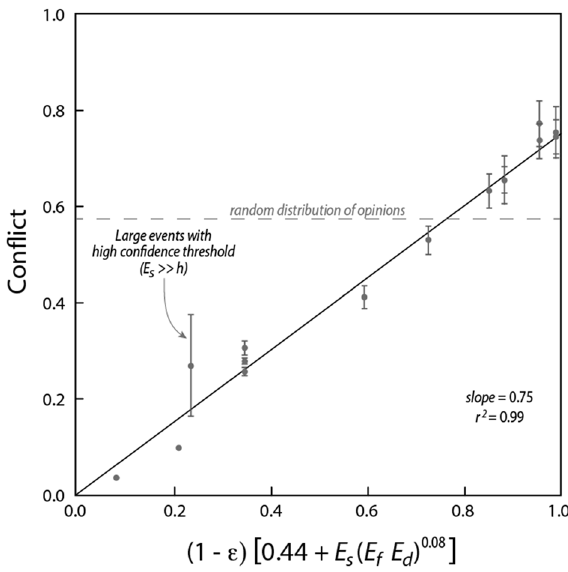
Figure 4. Average population conflict calculated from model results (over the period t = 500–1000 timesteps) plotted against the functional relationship defined by Eq. (6). The correlation was significant ( r = 0.99, N = 17, p < 0.001) with a slope of